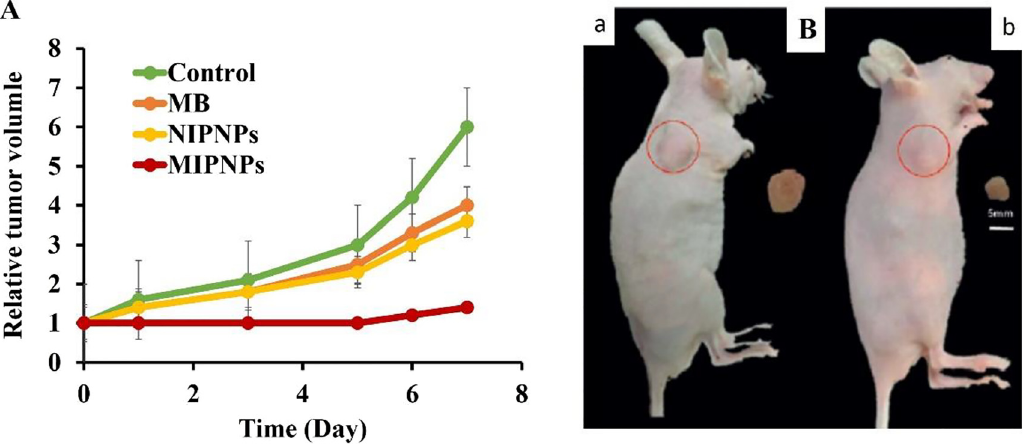
Figure 37: (A) In vivo antitumor effect of PDT on 4T1-tumor bearing mice performed using distinct NP formulations. All injections were performed once at t = 0, MIPNPs (1 mg/mL) loaded with the photosensitizer methylene blue (MB, 3 µm). Tumor volumes were measured every other day for one week. (B) Images of mice treated with (a) NIPNPs and (b) MIPNPs. Scale bar = 5 mm 650 nm laser light irradiation, 800 mW cm − 2 , 10 min. Adapted from Zhang et al. [86]. With permission from John Wiley and